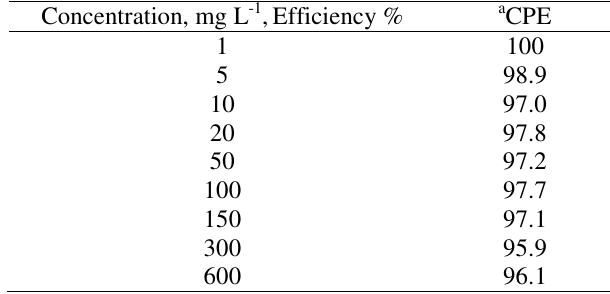
Table 1. Effect of initial dye concentration on the CPE efficiency of direct yellow 12 Concentration, mg L -1 , Efficiency %